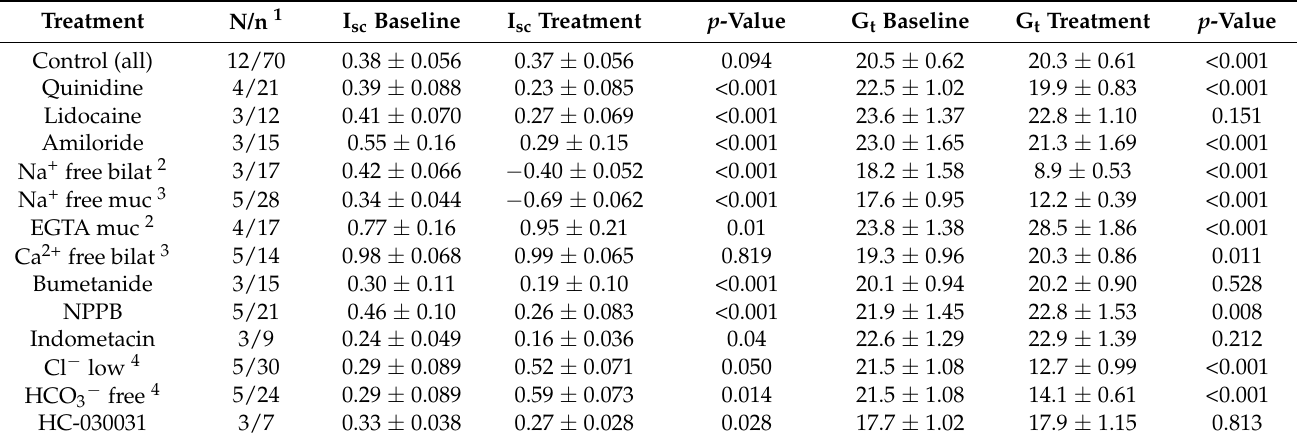
Table 1. Baseline I sc ( µ eq · cm − 2 · h − 1 ) and G t (mS · cm − 2 ) in colonic tissue from young pigs (controlled in-house study) (baseline) and the peak value in the 15 min interval after the addition of blockers or ion replacement (treatment). For the concentrations and solutions, see Results and Supplementary Materials.